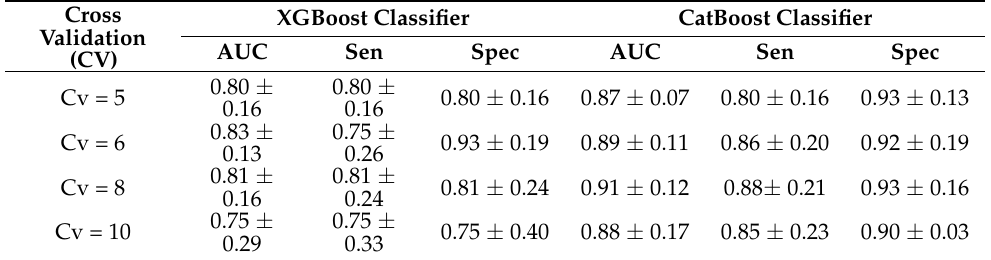
Table 4. Comparing performance of optimized (XGboost and Catboost) in terms of AUC, Sen., and Spec. Cross